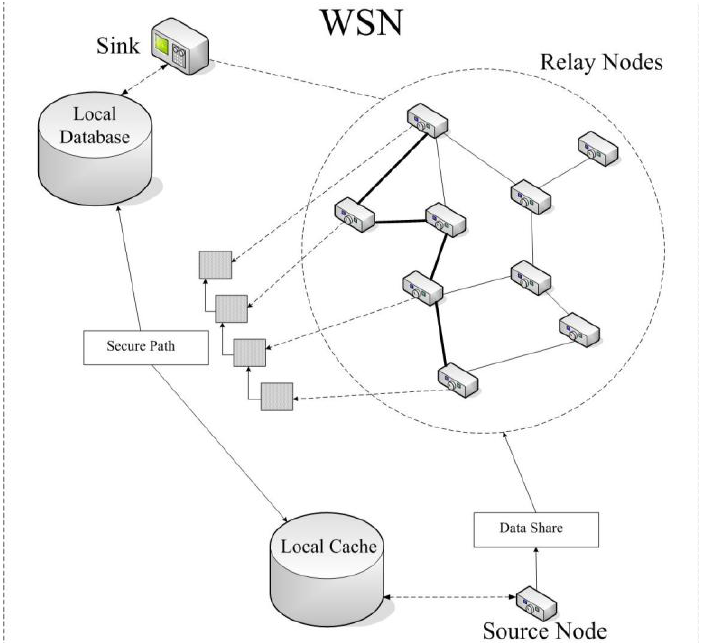
Figure 4. An illustration of the FSPC algorithm for secure data collection.